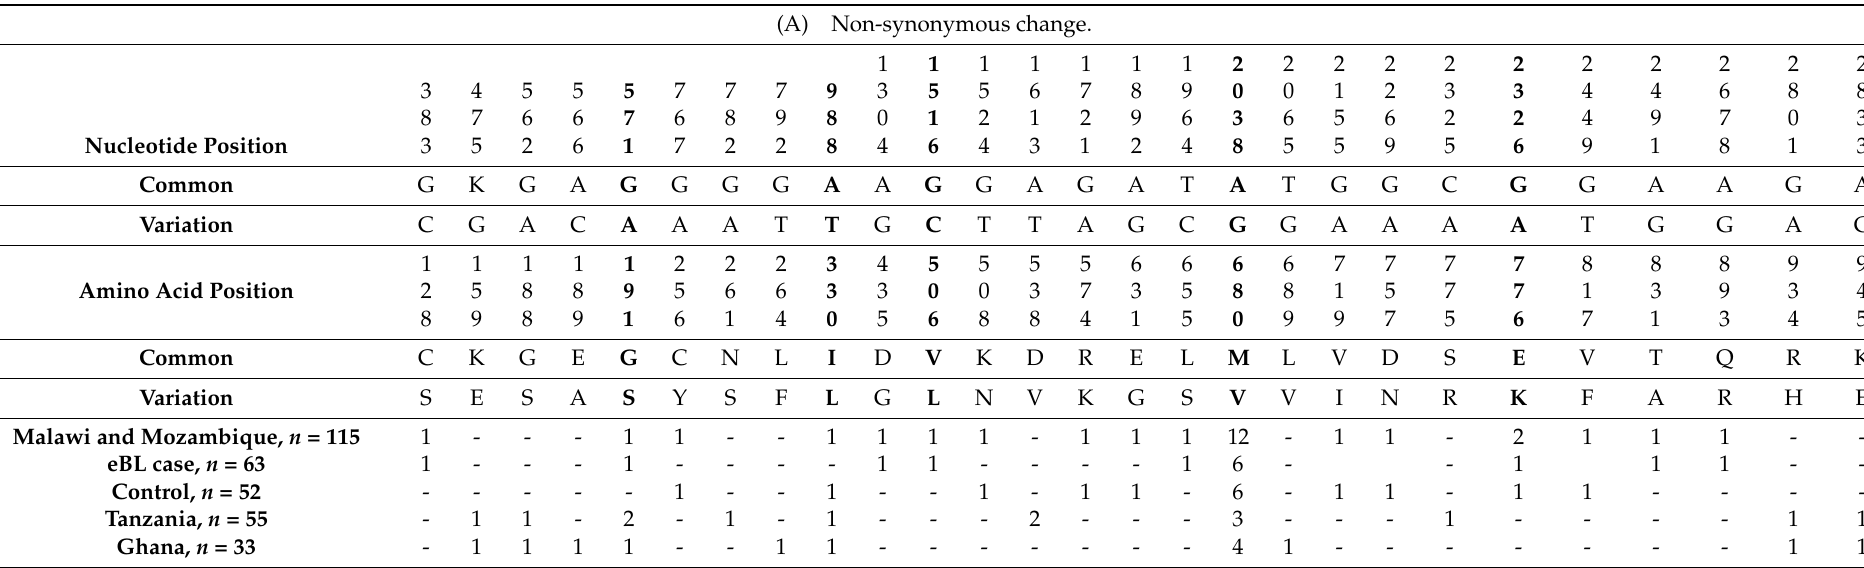
Table 4. Sequence variation in P. falciparum sera5 in the non-repeat 2562 bp region. Nucleotide and amino acid positions are numbered after the P. falciparum 3D7 sequence. The number of isolates with variations are shown. Variations shared with previously reported P. falciparum sera5 sequences in PlasmoDB (https://plasmodb.org/plasmo/ accessed on 23 October 2020) and NCBI (https://www.ncbi.nlm.nih.gov/ accessed on 23 October 2020) databases are shown in bold font. (A) Non-synonymous